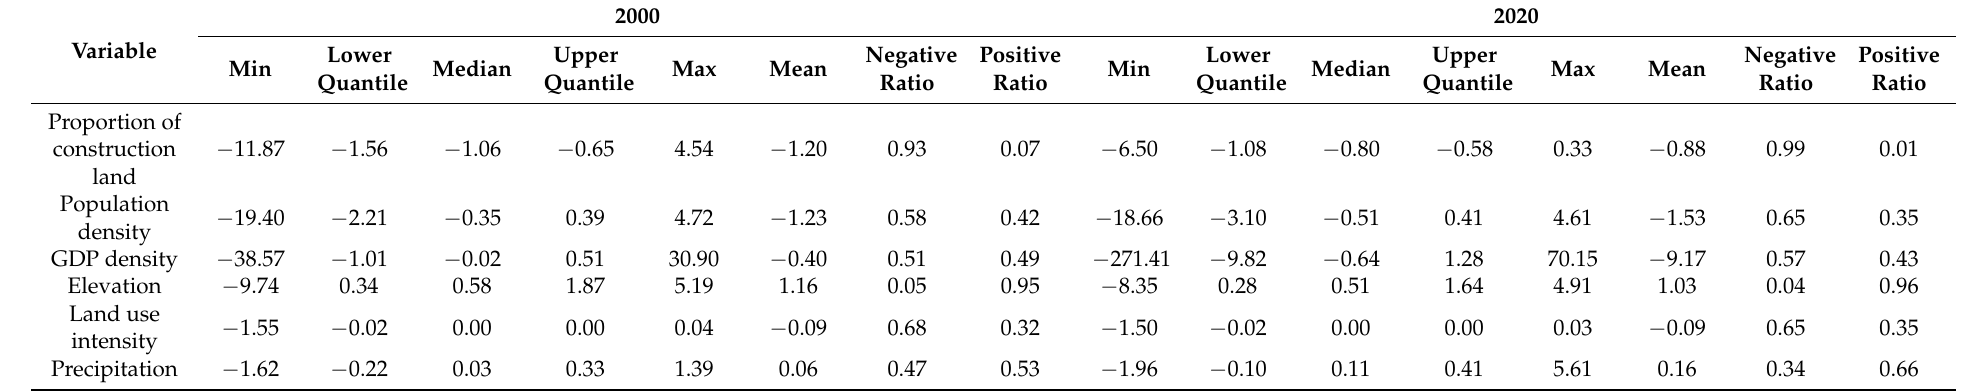
Table 4. Statistical results of the GWR model coefficient at the 5 km scale.